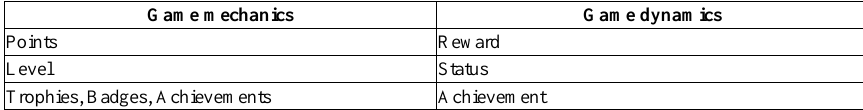
Table 2. Gamification Design/Model Used